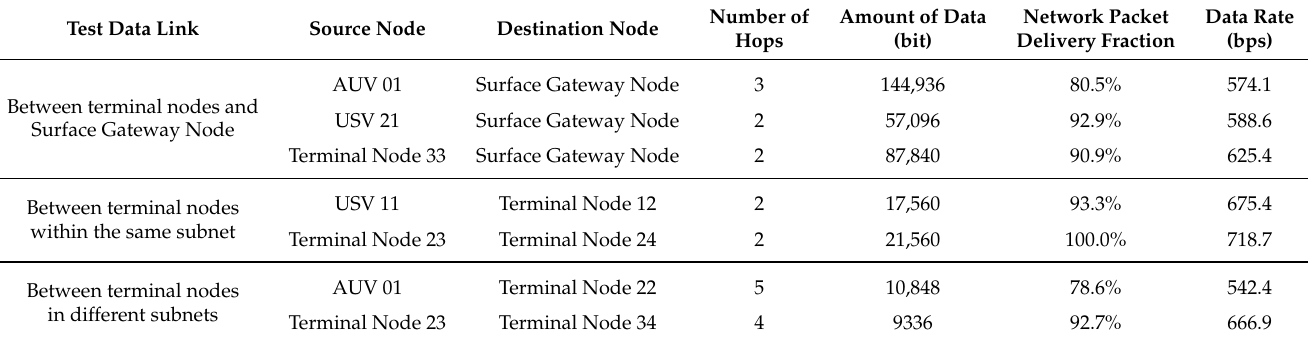
Table 2. Data rate test results for different data links.